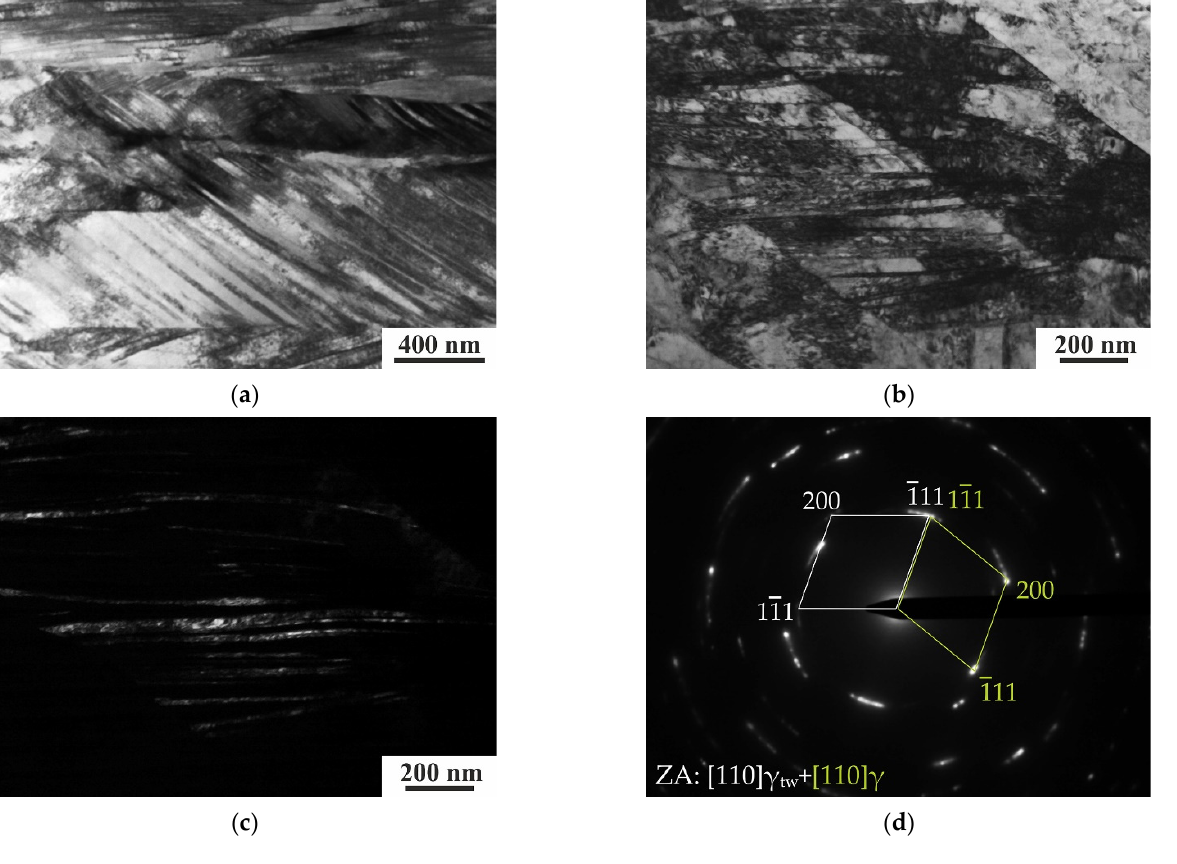
Figure 8. STEM and TEM images of steel microstructure after HTMT-3 + CR in the section perpen- dicular to TD. STEM image of fragmented structure with micro and nanotwins ( a ); BF image with fragmented plates and nanotwins ( b ), Dark-field image in g = 1–11 γ tw ( c ); SAED patterns with matrix zone axis [110] γ marked by yellow color and twin zone axis [110] γ tw —by white color ( d ). Table 2. Mechanical Properties of EK-164 Steel. Treatment Temp. Tensile Tests, ◦